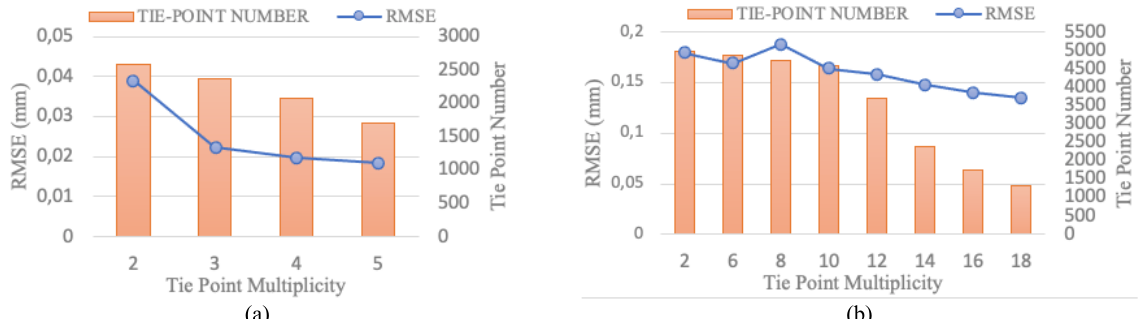
Figure 9 . RMSE of 3D points based on thetie points multiplicity analysis: straight (a) and closed (b) image